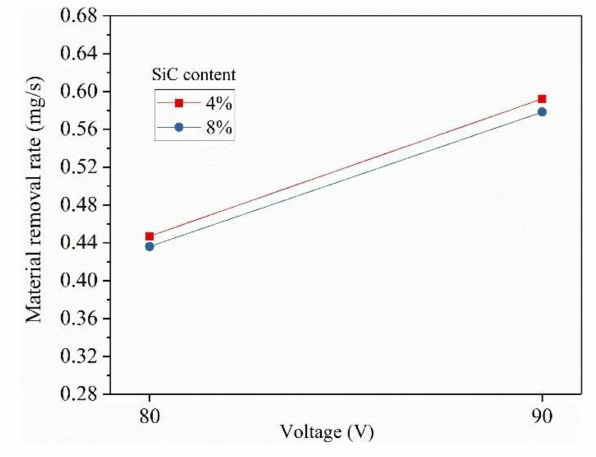
Figure 6. The effect voltage on MRR.